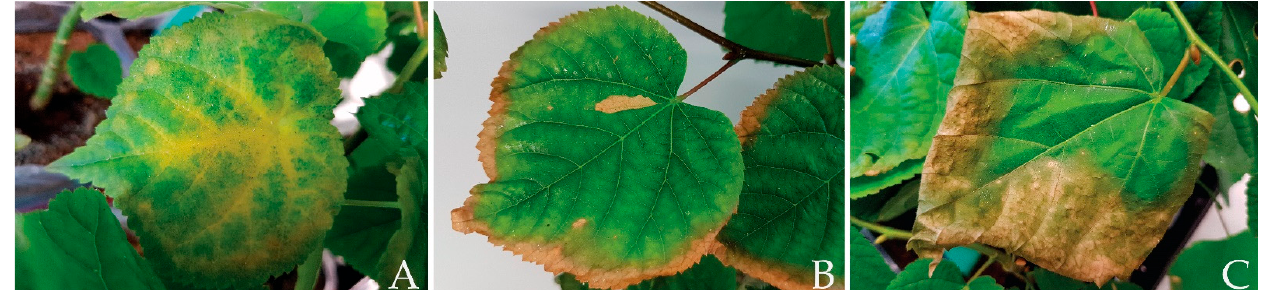
Figure 2. The leaf damage on T. cordata seedlings due to a high concentration of Na + ions. The first symptoms appeared after 35 days of salt treatment in the form of ( A ) leaf yellowing; ( B ) leaf edge burning; and ( C ) early leaf fall after 50 days of salt treatment.